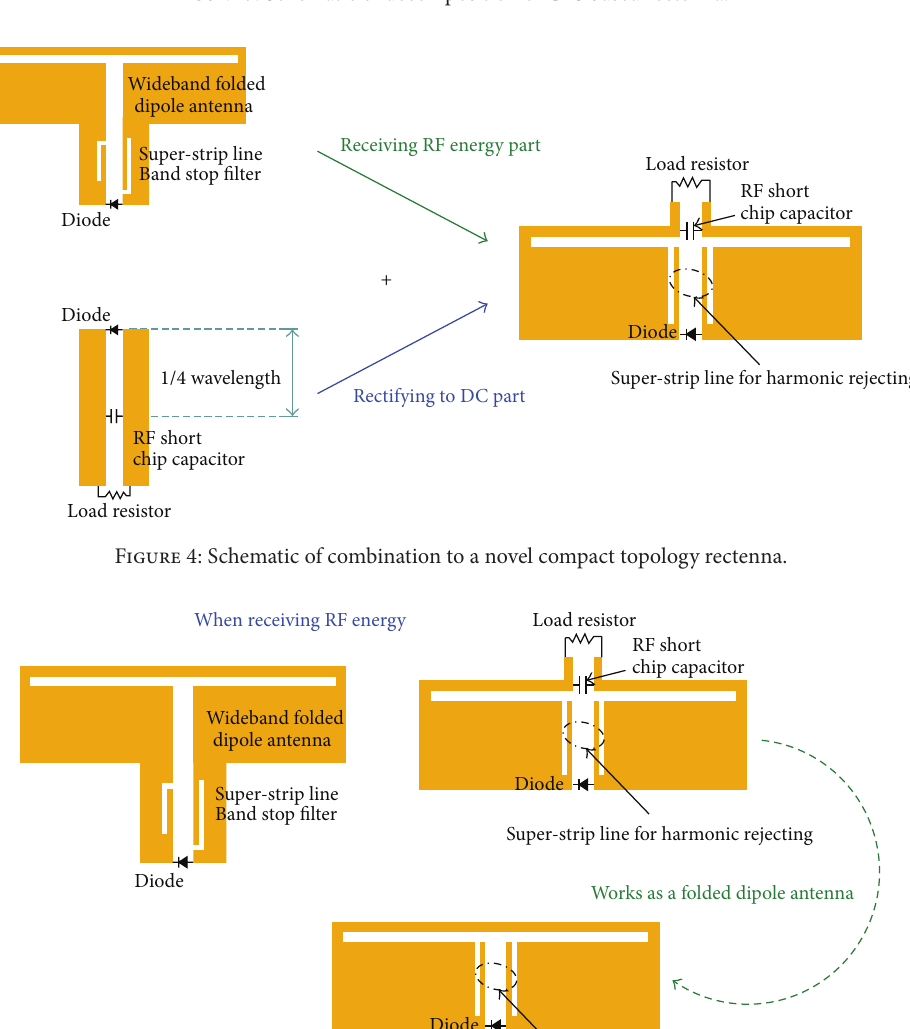
Figure 3: Schematic of decomposition of CPS based rectenna.